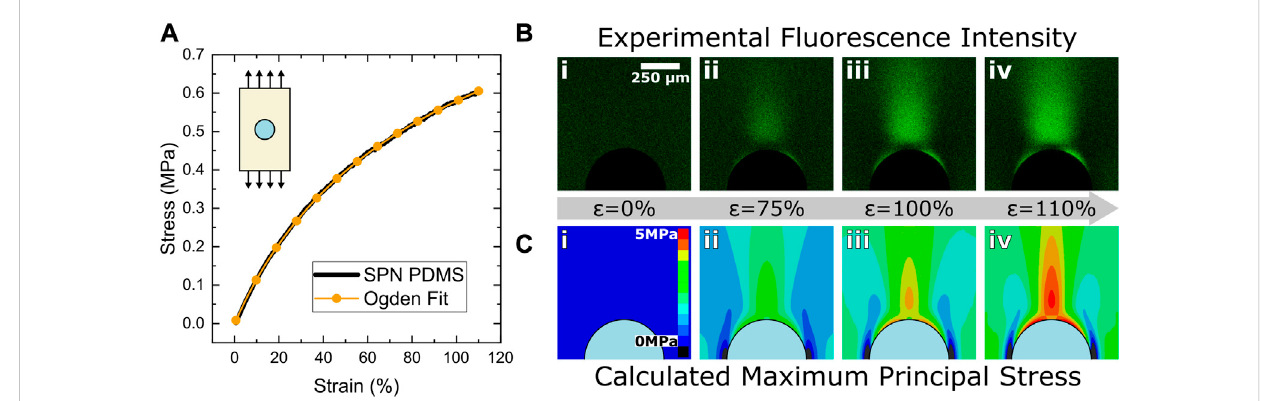
Fluorescence and stress evolution during mechanical loading. (A) Bulk material properties were characterized via quasistatic uniaxial tensile testing. The relationship between stress and strain was fi t with an Ogden hyperelastic model to determine materials constants for the fi nite element analysis simulations. The tensile response of a representative test is shown. (B) As the specimen is strained from 0% (i) to 110% (iv), the fl uorescence intensity increases, producing a characteristically shaped fl uorescence micrograph concentrated in the loading direction as well as at 30 ° relative to the stretching direction along the sides of the particle. The black semicircle at the bottom of each image is the top half of the particle. The scale bar in (i) applies to all images. (C) Predicted stress evolution through fi nite element analysis. Maximum principal stress is related to MP activation due to the stress orientation insensitivity observed by MPs. Stress concentrations in the loading direction occur due to tensile stresses while the stress concentration near 30 ° occurs due to shear stresses near the particle. Inset schematic in (A) indicates the stretching direction applied in image sequences in (B) and (C)